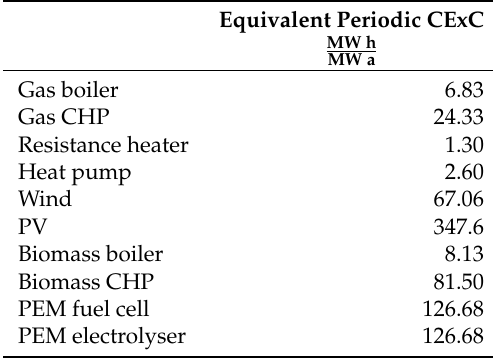
Table A7. Equivalent periodic CExC for conversion units and RES technologies.